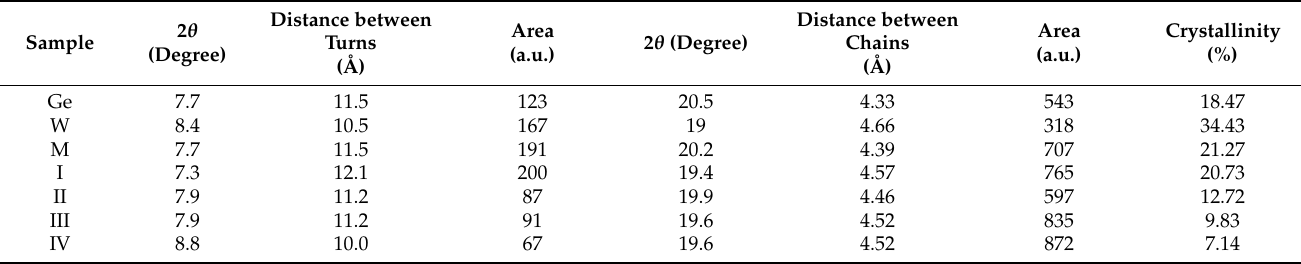
Figure 2. XRD spectra of starting compounds (whey (W), gelatin (Ge), and graphene oxide (GO)) and hydrogel samples: control sample (M) and samples with increasing concentration of GO (I, II, III, and IV). Table 1. Area of peaks and distance between turns in helical structure and polypeptide chains corresponding with 2 θ